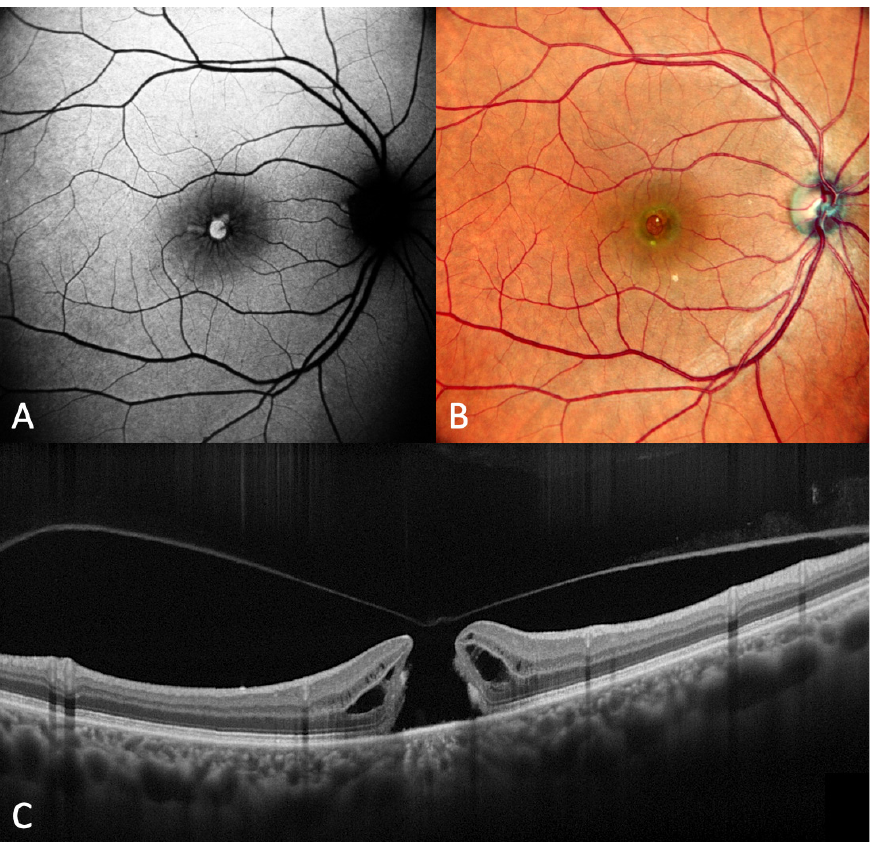
Figure 8. ( A ) Fundus autofluorescence (FAF) image of a full-thickness macular hole. FAF shows hyperautofluorescence in the macula. ( B ) Fundus photograph in the same eye. ( C ) Optical coherence tomography scan in the same eye.